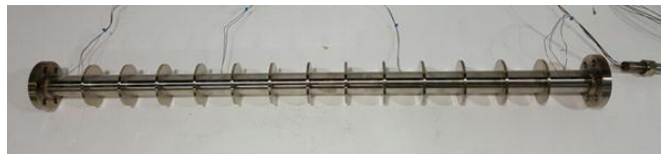
Figure 5. Photograph of the fabricated annular finned tube.